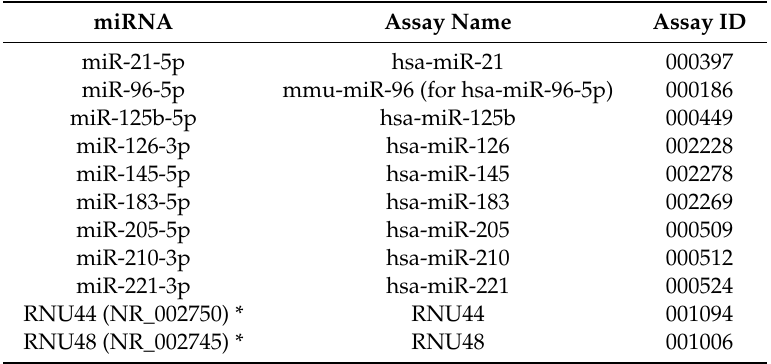
Table 6. The TaqMan microRNA assays used (Thermo Fisher Scientific, Darmstadt, Germany). miRNA Assay Name Assay ID miR-21-5p